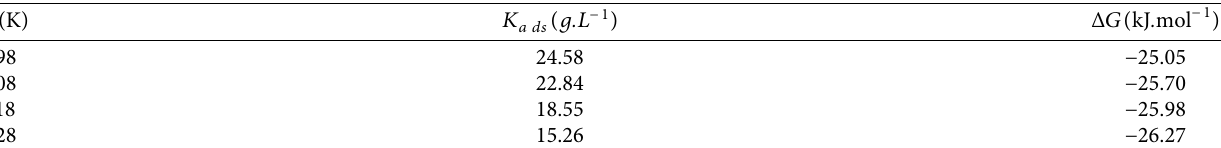
Table 3: Thermodynamic characteristics for 1M HCl adsorption on carbon steel at temperatures of 298; 308; 318; and 328K.